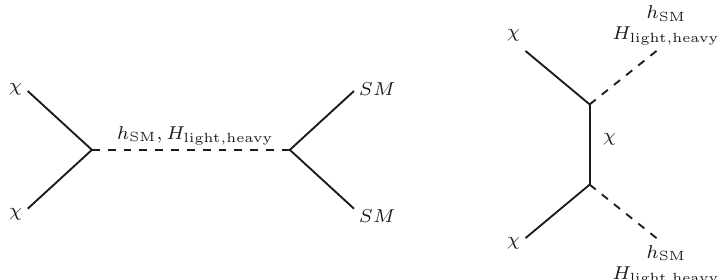
Figure 4 . DM ( (cid:31) ) annihilation process that yield relic density of the